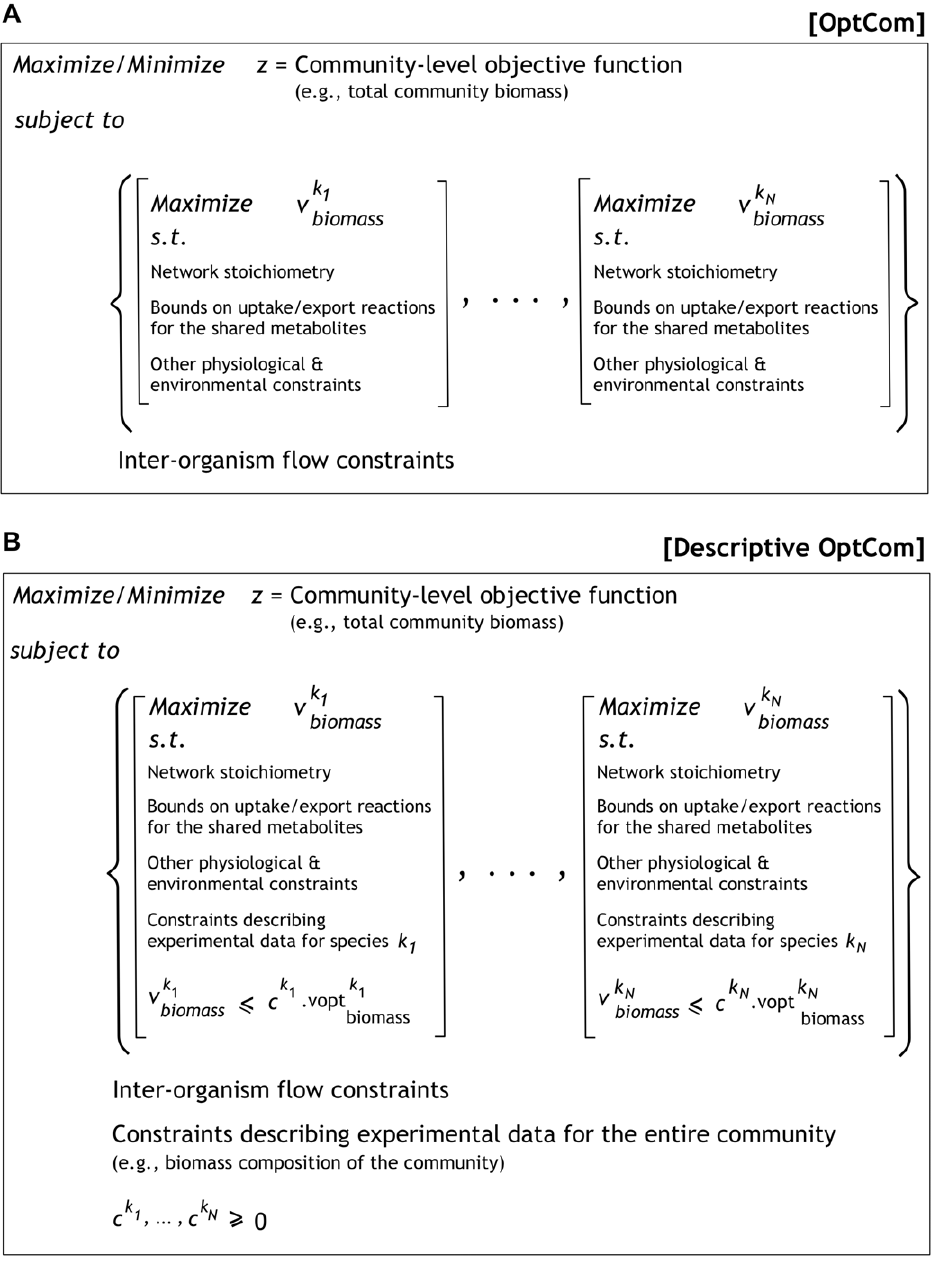
Figure 1. Schematic illustration of OptCom. (A) The multi-level optimization structure of the OptCom. A separate biomass maximization problem is defined for each species as inner problems. These inner problems are then integrated in the outer stage through the inter-organism flow constraint to optimize a community-level objective function. (B) Structure of the Descriptive OptCom to determine the optimality level of each species ( c k ), given a set of experimental data. The available experimental data for the entire community and the individual species are described using constraints in the outer and inner problems, respectively, whereas, sub- or super-optimal behavior of each microorganism is captured by using a constraint for the respective inner